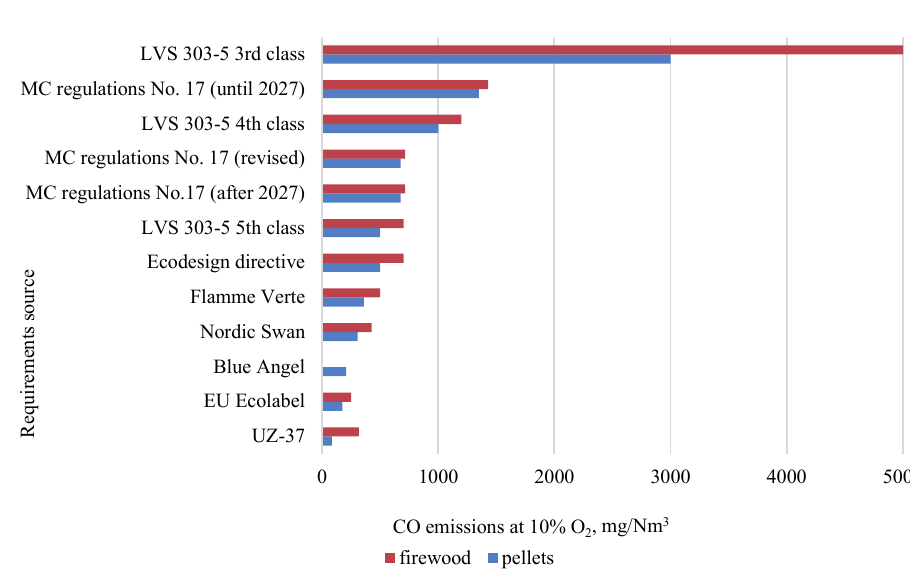
Fig. 4. Requirements for CO emissions at 10 % O 2 .